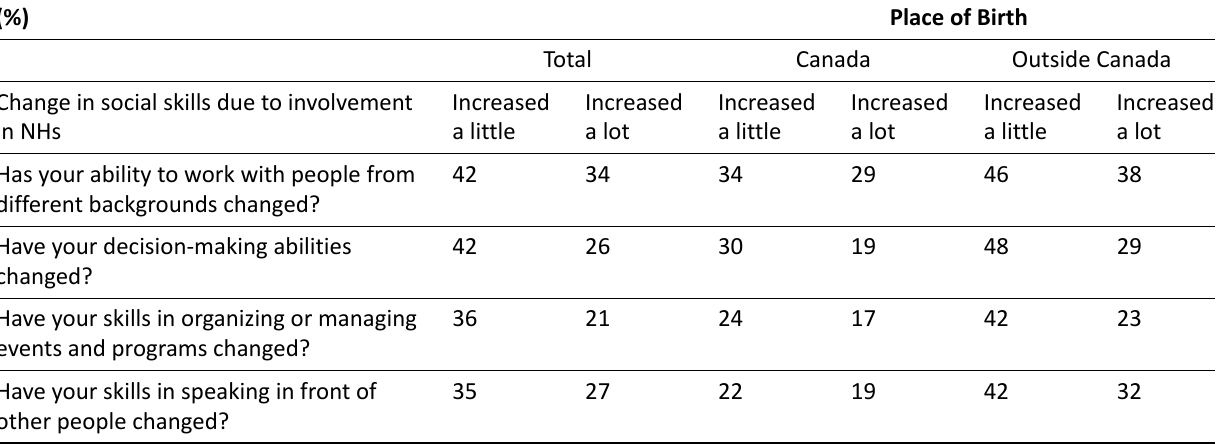
Table 1. Perceived changes in social skills through involvement at NHs.